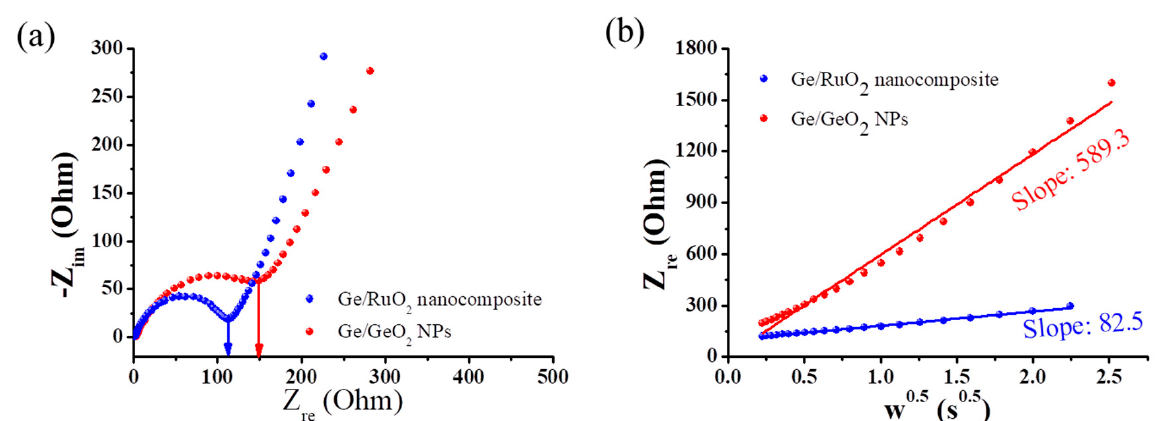
Figure 6. ( a ) Nyquist plot and ( b ) Warburg plot of Ge/GeO 2 NPs and Ge/RuO 2 nanocomposite.